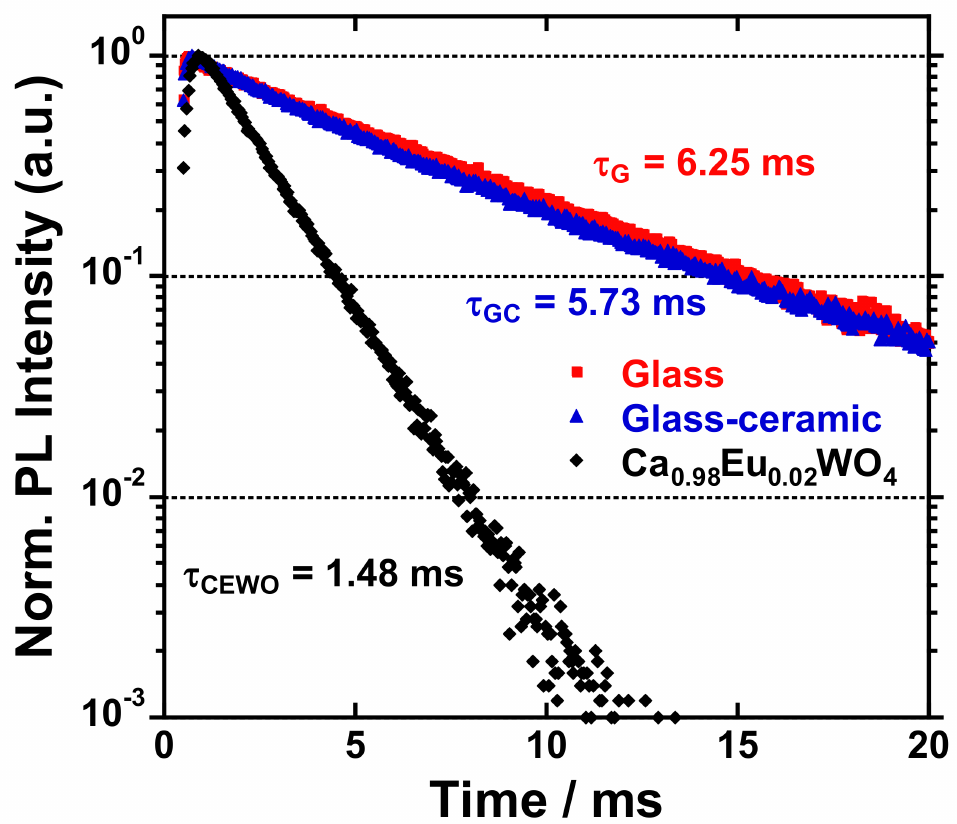
Figure 9. Eu 3+ PL decay curves of the 15mol% Ca 2.98 Eu 0.02 WO 6 samples (the pristine glass and glass-ceramic) and Ca 0.98 Eu 0.02 WO 4 crystal ( λ ex = 394nm, λ em = 613nm). The evaluated PL lifetime was τ G = 6.248 ± 0.007 ms (the pristine glass), τ GC = 5.735 ± 0.008 ms (the glass-ceramic), and τ CEWO = 1.479 ± 0.001 ms (the Ca 0.98 Eu 0.02 WO 4